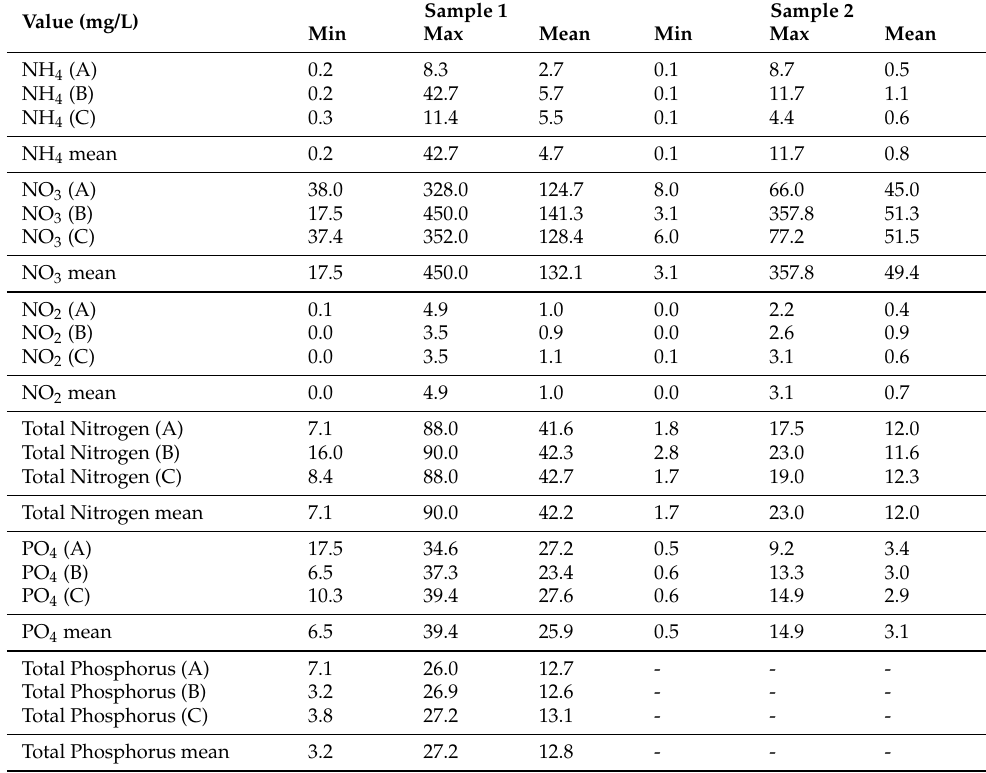
Table 3. Quality of treated wastewater (sample 1) and renewed water (sample 2) in terms of biogenic substances concentration. The letters A, B and C refer to three different hydraulic loads: 70, 100 and 130 L/m 2 ,